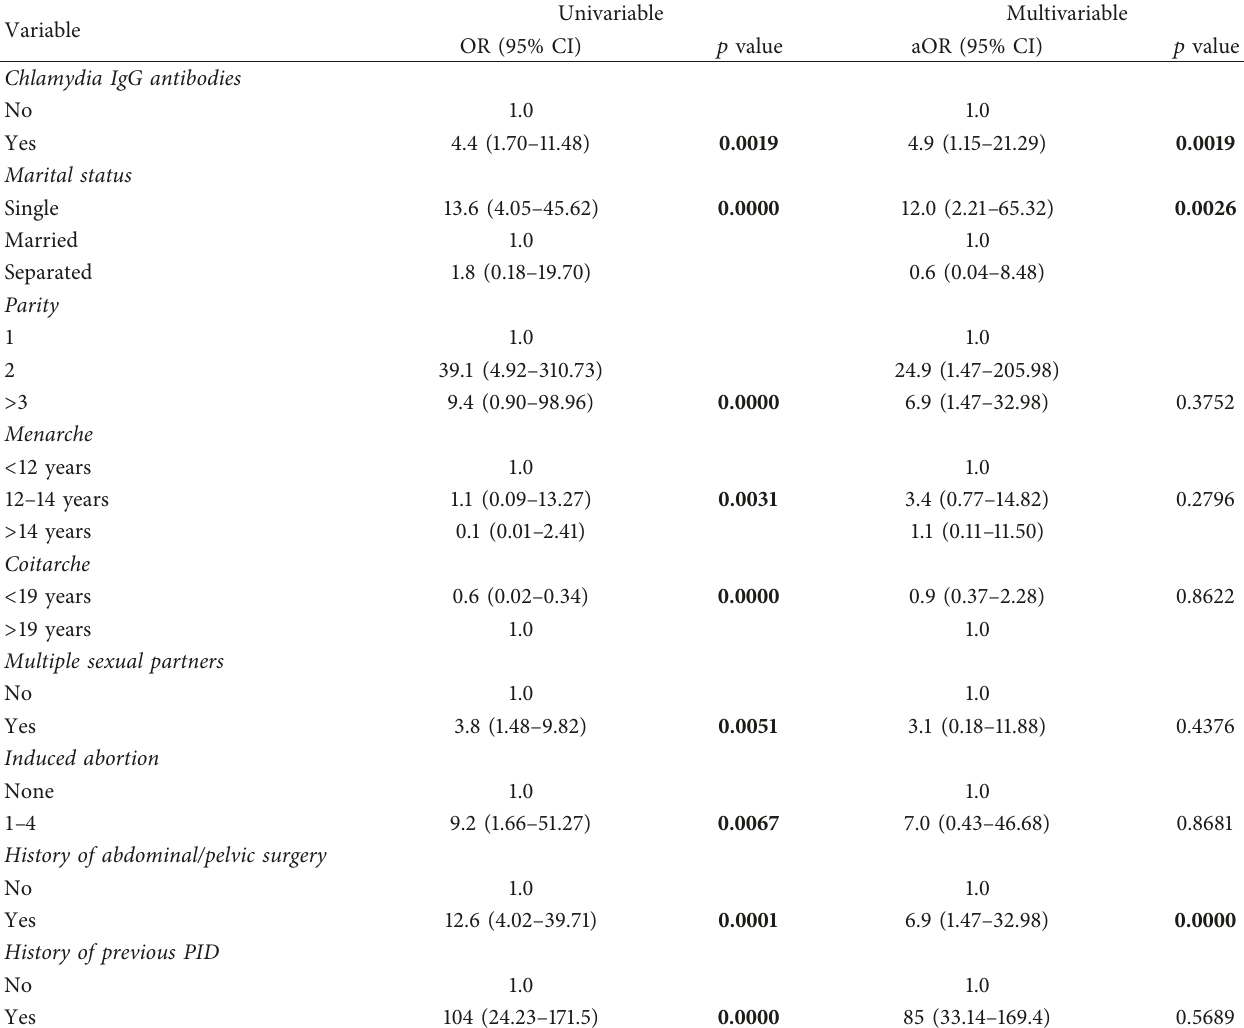
Table 4: Factors associated with ectopic pregnancy at multivariate